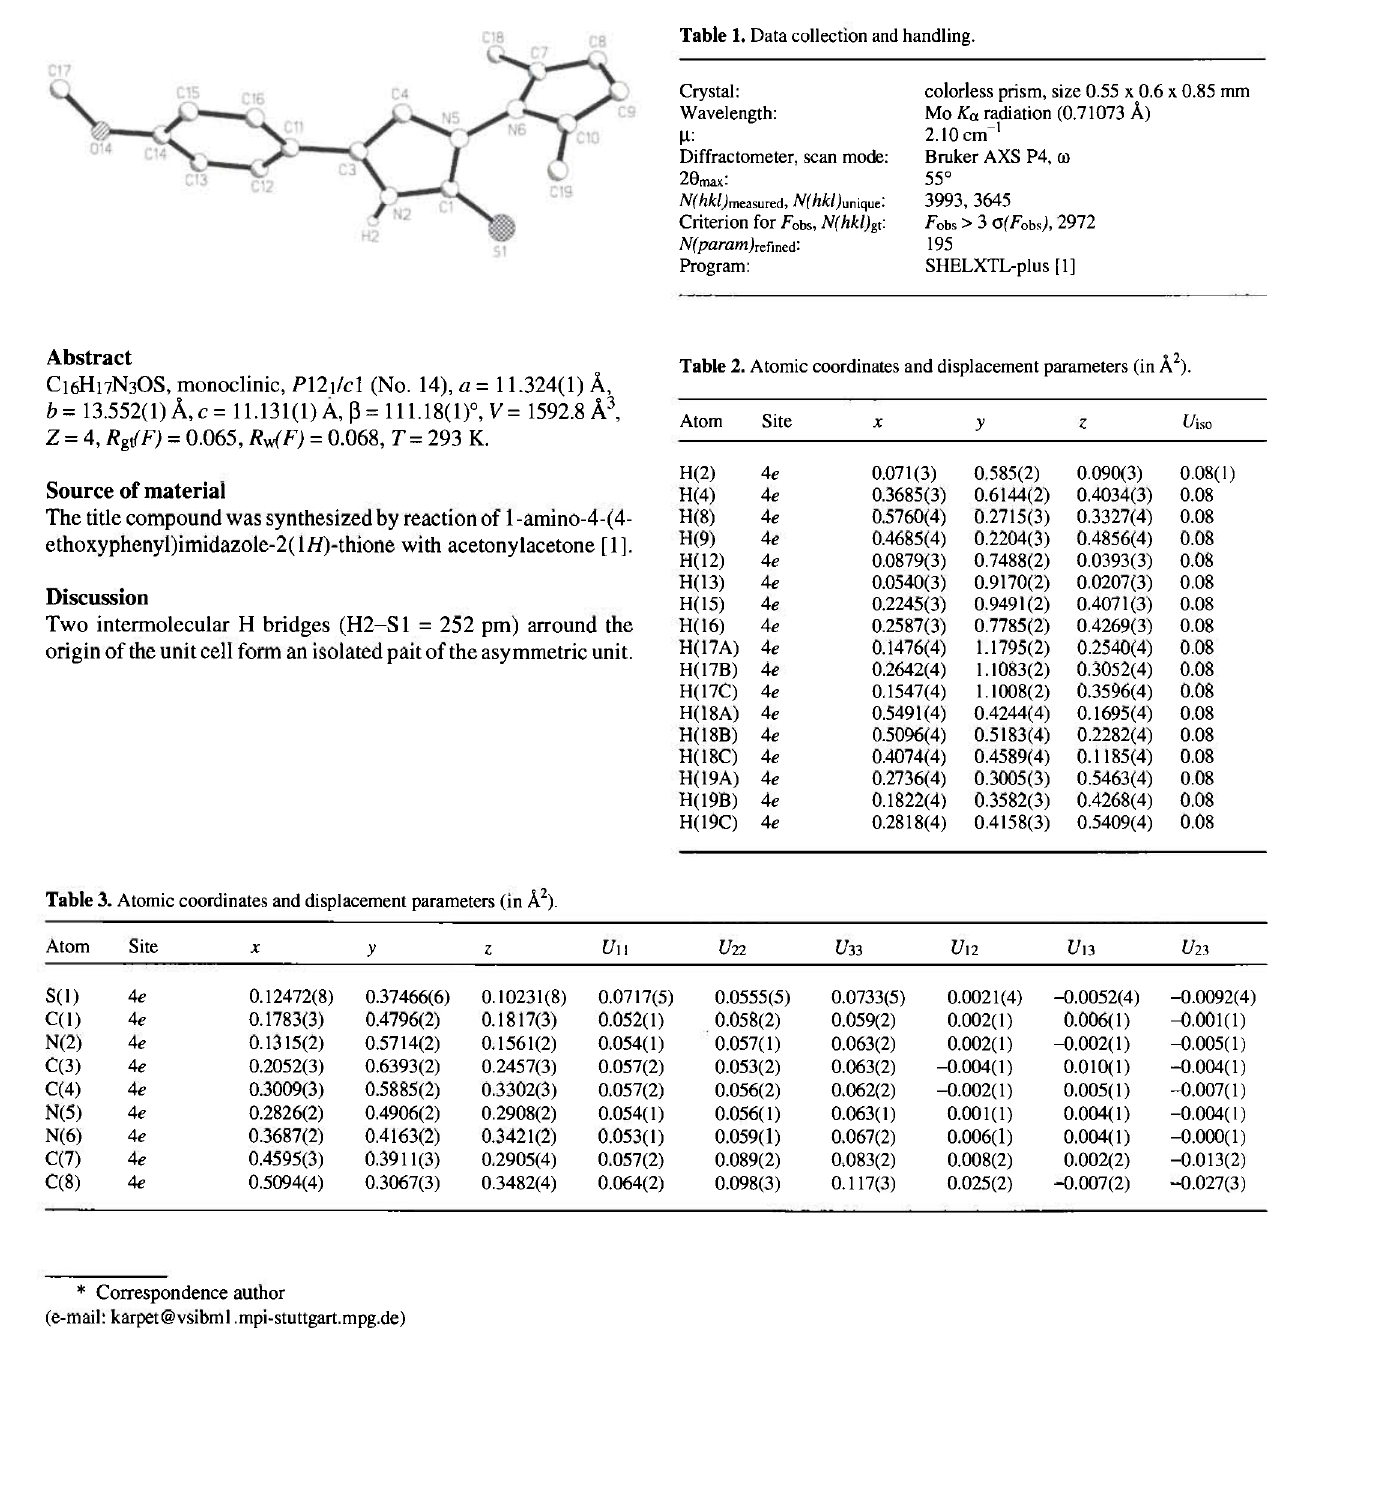
Table 1. Data collection and handling.